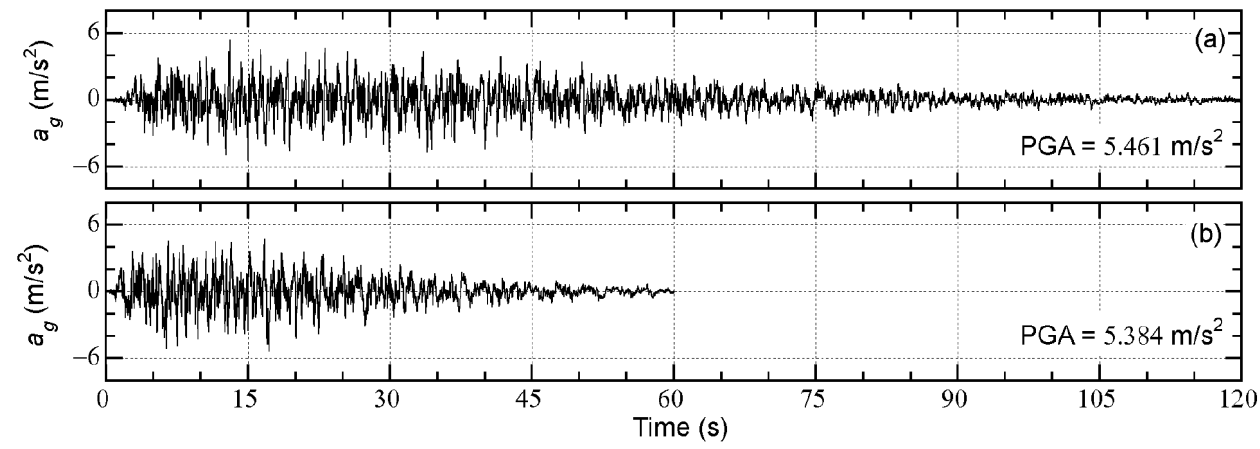
where ∆ φ 0 is the constant used to shift the phase angle of all harmonics. As in previous studies [28,30,31], ∆ φ 0 varies from π /12 to 11 π /12 at intervals of π /12. The generated artificial ground motions are numbered from 01 to 11 accordingly. A total of 2 × 12 = 24 artificial ground motions are used in this study. changes in the phase angle is very limited.